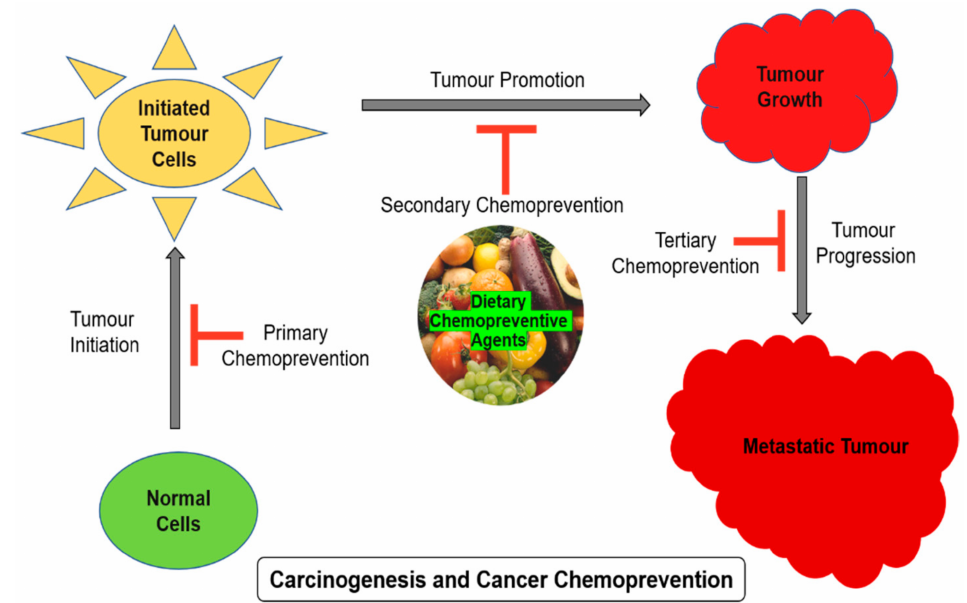
Figure 1. Stages of carcinogenesis and